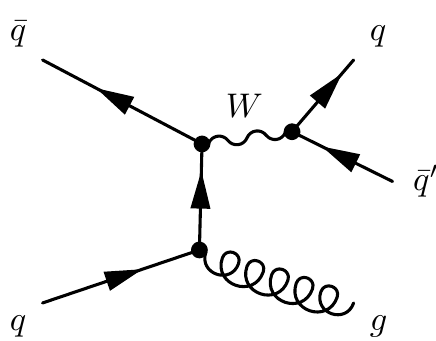
Figure 1 . Illustrative Feynman diagram showing the production of a W boson together with an additional parton, where the W boson decays to a quark anti-quark pair, q (cid:22) q 0 . neutrino decay mode. Only its transverse mass can be extracted by estimating the neu- trino transverse momentum from the measured missing transverse momentum in the